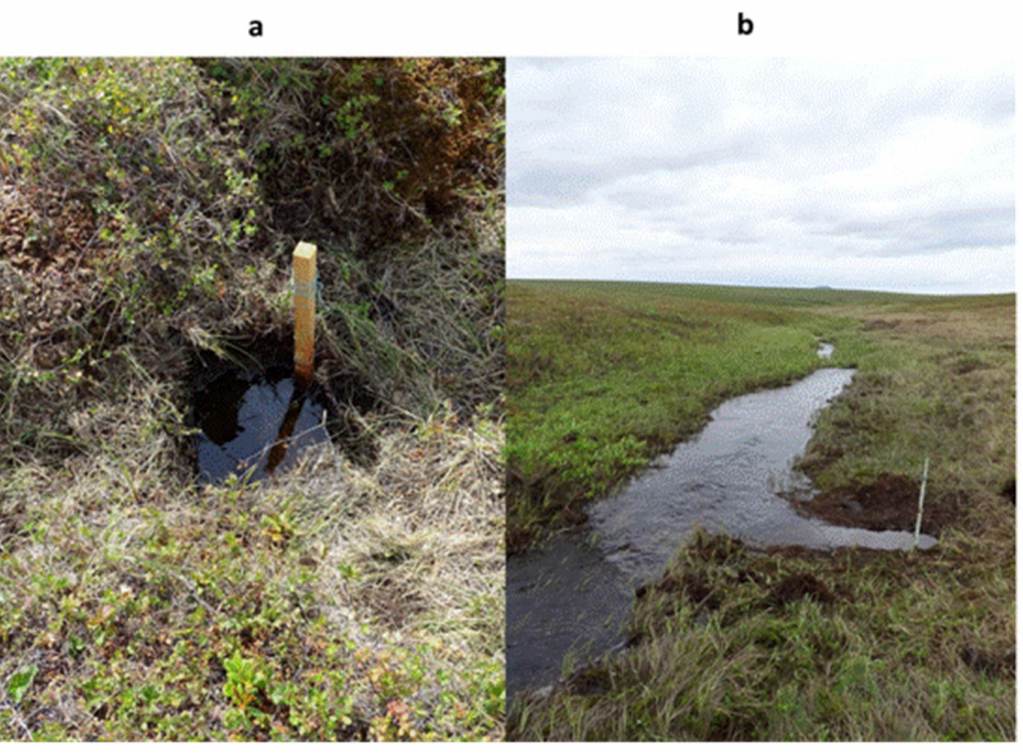
Figure 4. General view of ( a ) pit No. 2 at the hollow and ( b ) pit No. 3 in the Yagodnyi Creek.